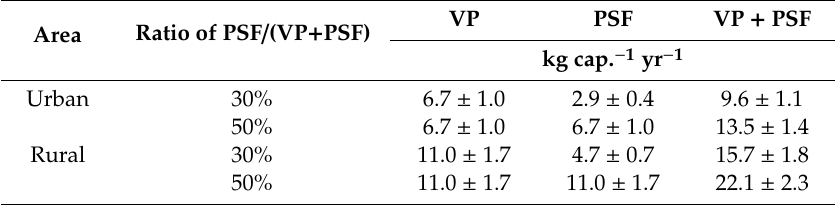
Table 2. Required per capita potato-as-vegetable (VP) and potato-as-a-staple food (PSF) consumptions, under the goals of 30% and 50% of PSF consumption in China’s urban and rural areas in